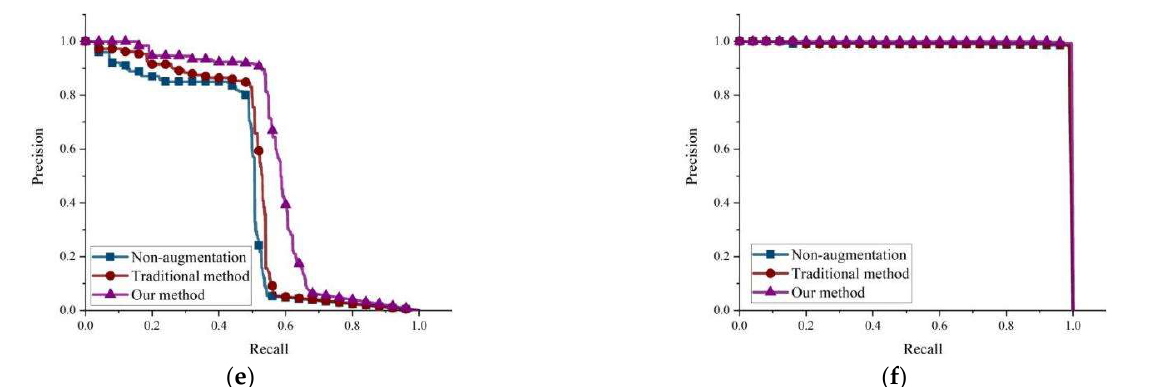
Figure 17. Comparison of PR curves. ( a ) all; ( b ) coal; ( c ) gangue; ( d ) bag; ( e ) iron; ( f ) wood.